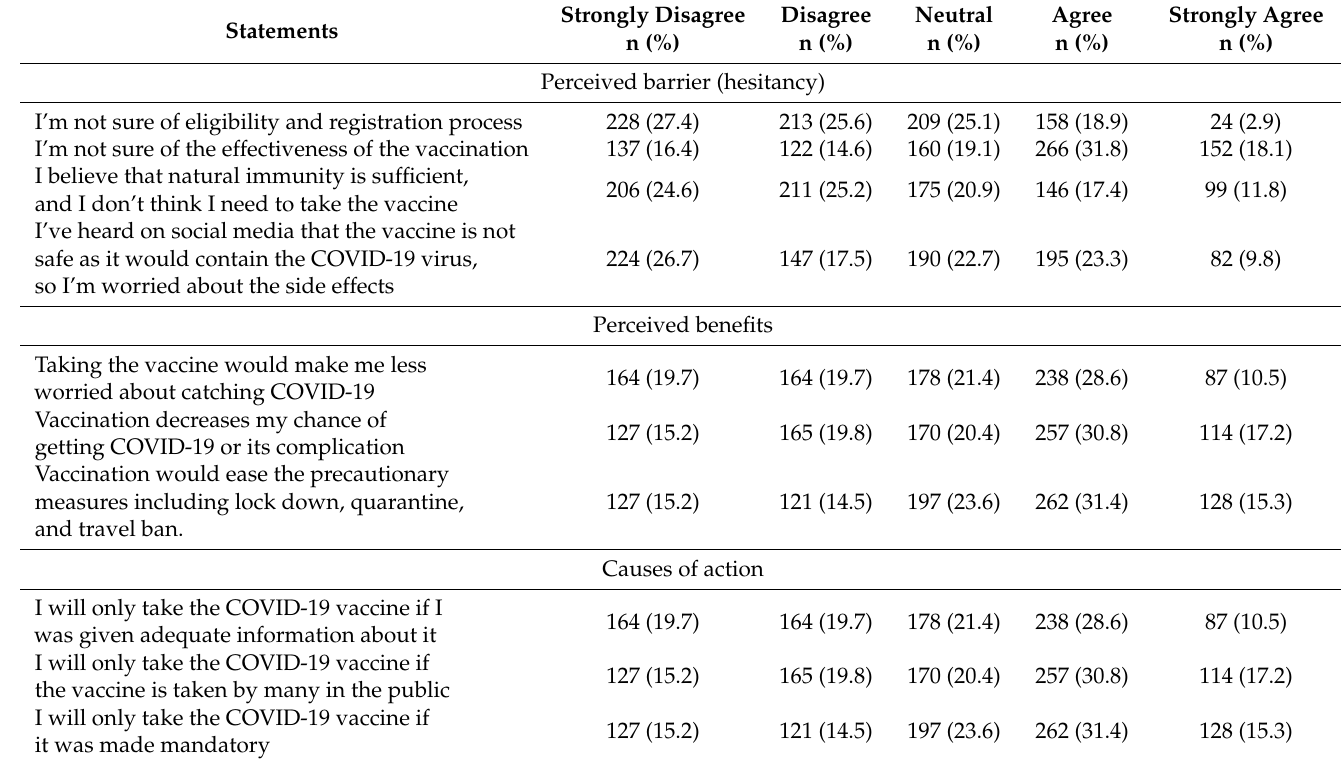
Table 3. Reasons for hesitancy, perceived benefits, and causes of